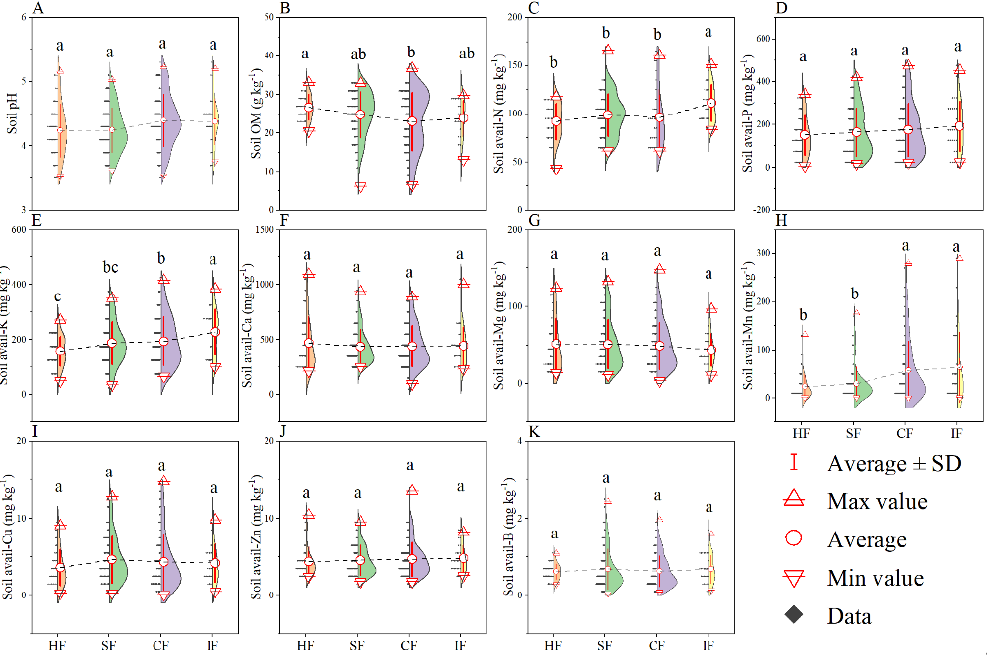
Figure 5. Content of trace elements in Guanxi pomelo soil in Pinghe. HF (47 samples): high-quality fruit, SF (97 samples): sub-quality fruit, CF (106 samples): Common fruit, and IF (31 samples): inferior fruit. Soil OM: soil organic matter; soil avail-N: soil available nitrogen; soil-P: soil available phosphorus; soil avail-K: soil available potassium; soil avail-Ca: soil available calcium; soil avail-Mg: